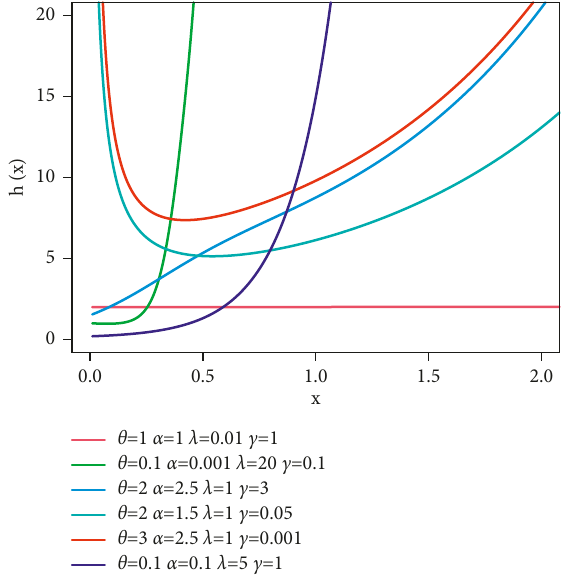
Figure 2: The hrf plot for the MOEGM